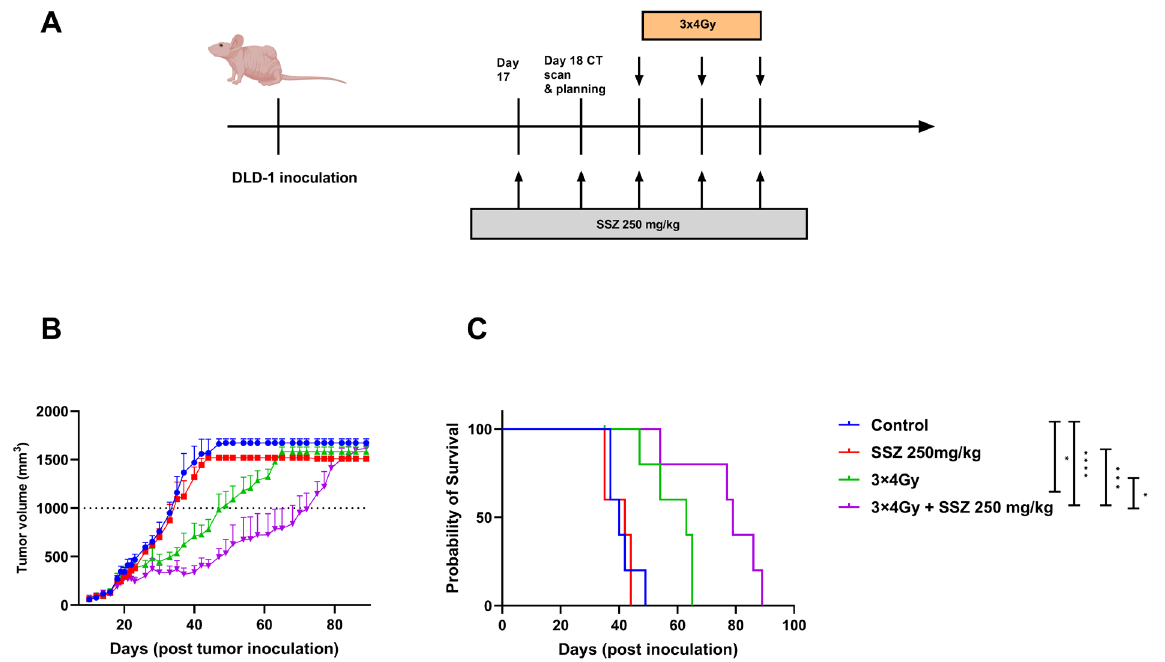
Figure 7. Sulfasalazine synergizes with radiation in DLD-1 xenografts. ( A ) Experimental setup for the treatment of the DLD-1 xenografts in vivo. ( B ) Tumor growth curve, day 0 displays the inoculation of the DLD-1 tumor cells. ( C ) Survival curves of mice, inoculation of the DLD-1 tumor cells is depicted as day 0. Data are shown as mean ± SEM. Results are shown of 1 representative experiment of 2 repeats ( n = 5). A one-way ANOVA followed by Dunnett’s multiple comparison test was performed for statistical analyses. * p < 0.05, *** p < 0.001, **** p < 0.0001 .